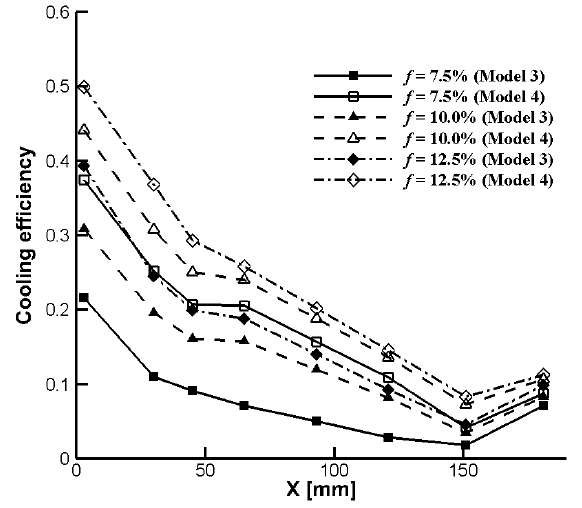
Figure 10. Distribution of the cooling efficiency along the axial direction with a constant outlet area of film orifices.